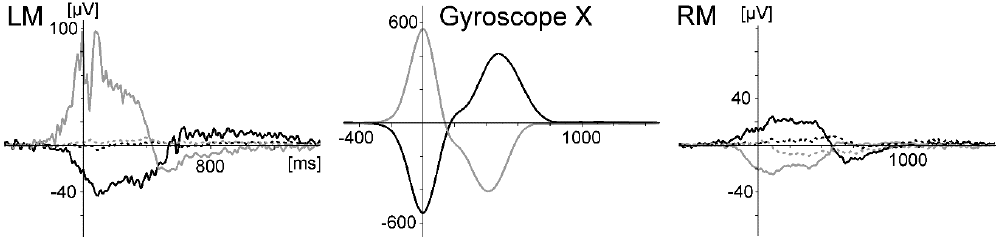
Figure 7. Movement artefacts generated by repeated rapid head rotations (measured with the gyroscope) at the left mastoid (LM, where the artefact was largest) and right mastoid (RM, both sites referenced to Cz). Rotations to the right side: black lines; rotations to the left side: grey lines. The polarity was inverted between left and right electrode sites (due to the Cz reference) and between left and right head rotations, which may depend on the activated part of the neck muscles (left or right). This artefact was present (with comparable amplitudes) at left sites C3 and O1, at right sites C4, FC2, CP2, and RM, and at O1, Fz, and AFz. Using independent component analysis (ICA)-based correction, the artefact could be removed nearly completely (dotted lines). The gyroscope was not calibrated (arbitrary units).